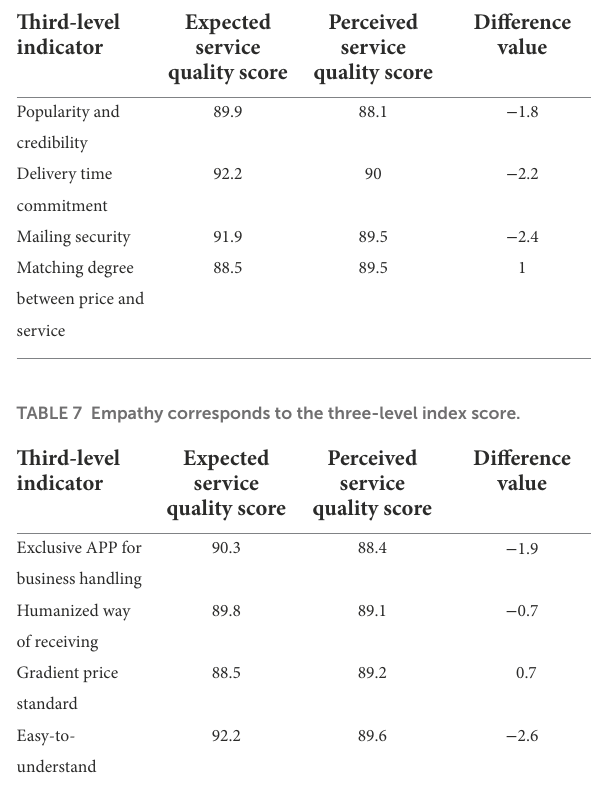
TABLE 6 Reliability corresponds to the third-level index scores.